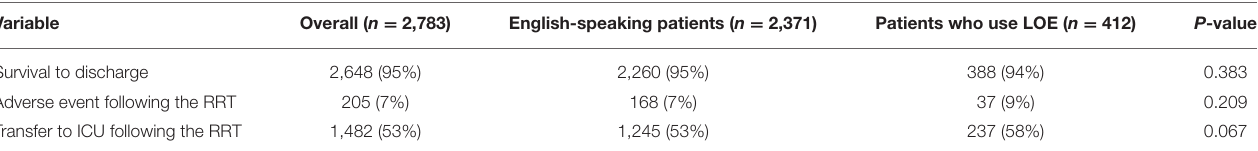
TABLE 2 | RRT-level summary of each of the three RRT-level measured outcomes, for 2,783 included RRTs. Variable